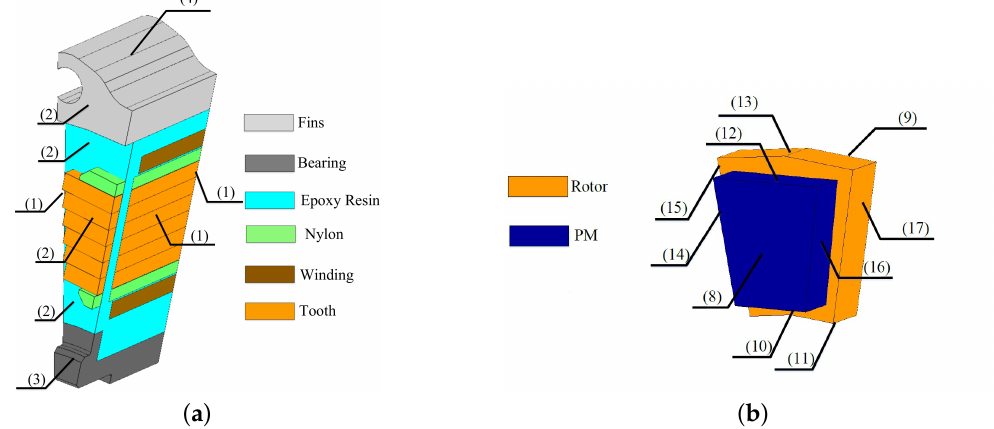
Figure 3. Stator and rotor modeled parts: ( a ) One quarter of the stator tooth: (1) thermal insulation; (2) stator facing rotor upper part; (3) stator facing rotor lower part; (4) stator side wall. ( b ) Modeled rotor part:(8) rotor facing stator upper; (9) rotor left side; (10) PM lower; (11) rotor lower; (12) PM upper; (13) rotor upper; (14) PM left; (15) PM right; (16) rotor facing